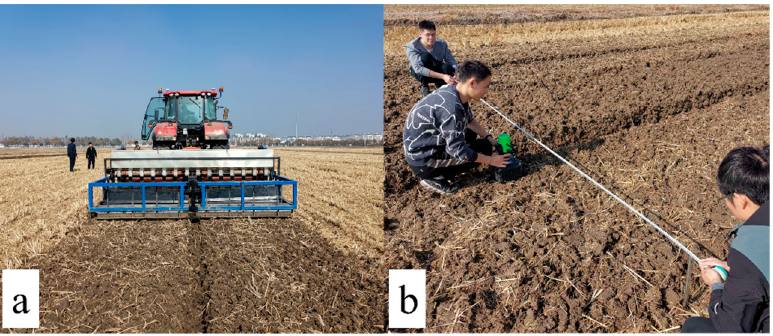
Figure 8. Diagram of test equipment and test site. ( a ) test equipment. ( b ) test site.